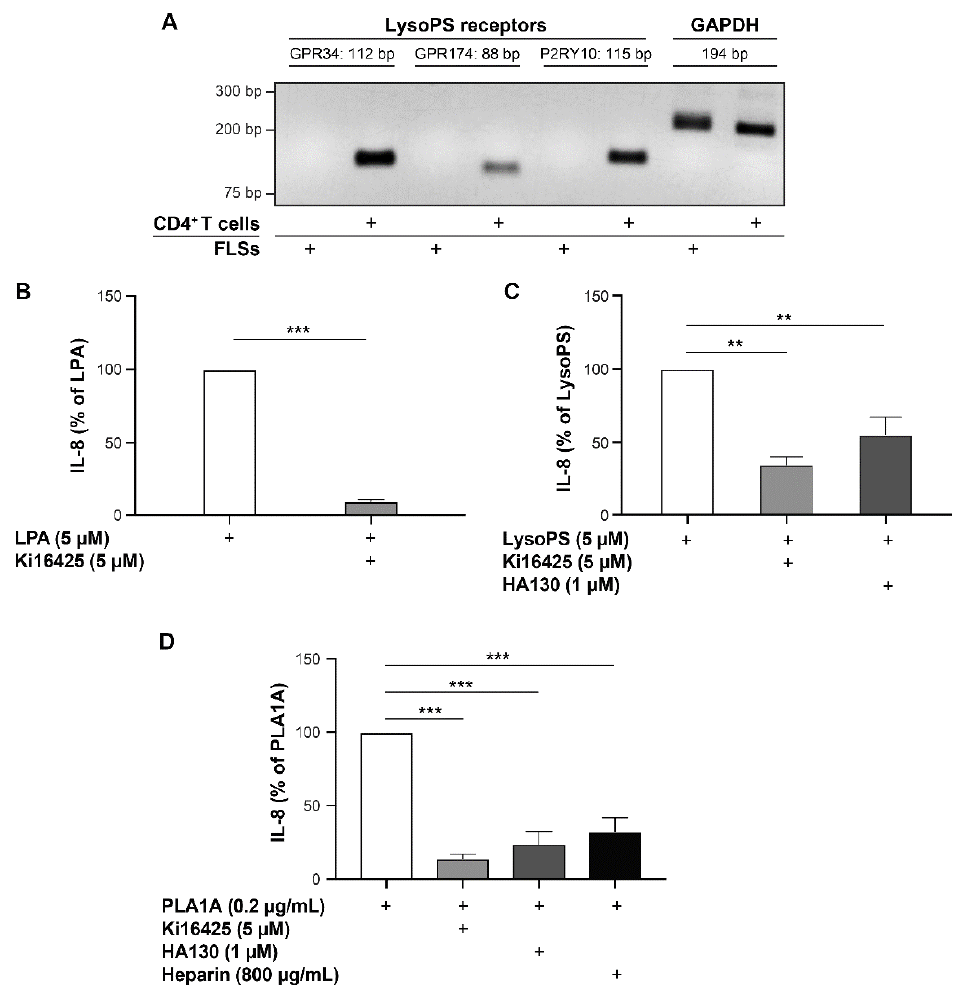
Figure 5. Pro-inflammatory effects of LPA, lysoPS, and PLA1A in human primary FLSs. ( A ) Total RNA from human primary FLSs from normal donors were tested for the expression of lysoPS receptors using semi-quantitative RT-PCR. For each lysoPS receptor (GRP34, GPR174, and P2RY10), three pairs oligo primers were tested. Data shown are results of one pair primer for each receptor. GAPDH was used as a house-keeping gene. Total RNA from human CD4 + T memory cells was used as a positive control. ( B – D ) Human primary FLSs from normal donors were treated with 5 µ M LPA ( B ), or 5 µ M lysoPS ( C ), or 0.2 µ g/mL PLA1A ( D ) in the presence of 5 µ M Ki16425 or 1 µ M HA130 or 800 µ g/mL heparin for 24 h. Ki16425, HA130, and heparin were added to cell culture 30 min prior to LPA, lysoPS, and PLA1A. The amounts of IL-8 released in the supernatants were monitored using ELISA. IL-8 produced by FLSs stimulated with LPA, lysoPS, and PLA1A was 18.17 ± 7.19, 55.65 ± 22.6, and 23.11 ± 7.44 pg/mL, respectively. For each experiment, stimulated IL-8 production without inhibitors was set at 100% for data normalization. The data are the means ± SE from three experiments. For statistical comparative analyses, cytokine amounts in cells stimulated with LPA or lysoPS or PLA1A were compared to that in cells stimulated in the presence of Ki16425 or HA130 or heparin. ** p < 0.01; *** p <